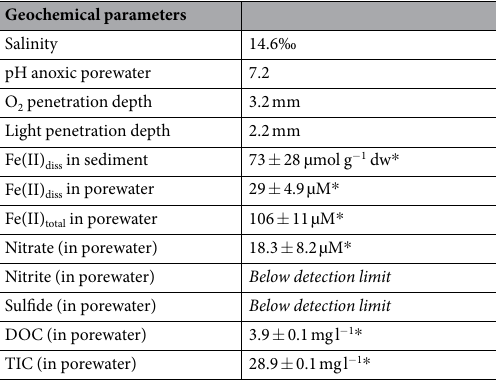
Table 1. Geochemical parameters of sediment from Norsminde Fjord in Denmark. Detailed sediment geochemistry description see Laufer et al . 8 . * Mean value for measurements in the upper 3 cm of the